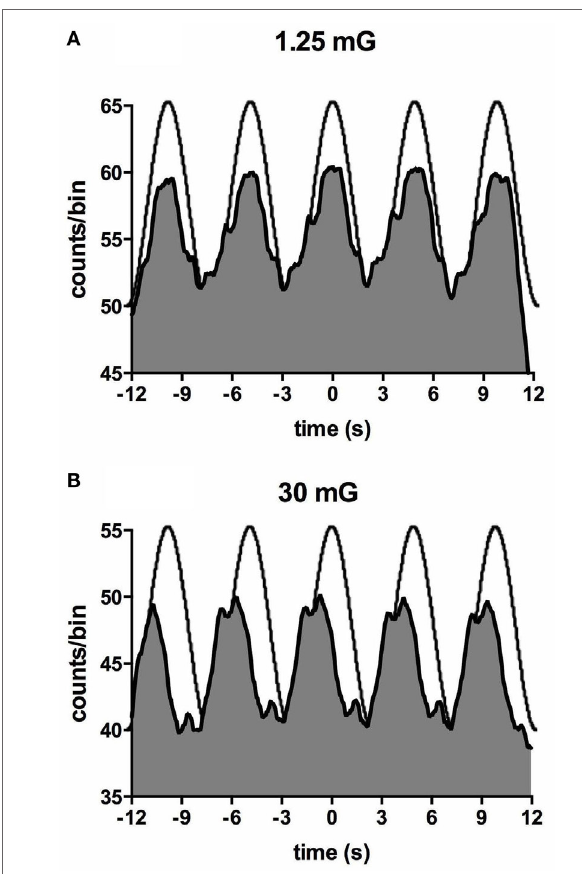
FiGURe 9 | Cross-correlation histogram between muscle sympathetic nerve activity and acceleration in the anteroposterior direction for one subject exposed to accelerations of 1.25 mG (A) and 30 mG (B) . The histograms have been fitted with a smoothed polynomial. The superimposed sinusoid schematically represents the acceleration profile of the platform: motion in the forward direction is indicated by the positive phase of the sinusoid, which includes the period of acceleration before the peak and deceleration after the peak. Reproduced with permission from Hammam et al.